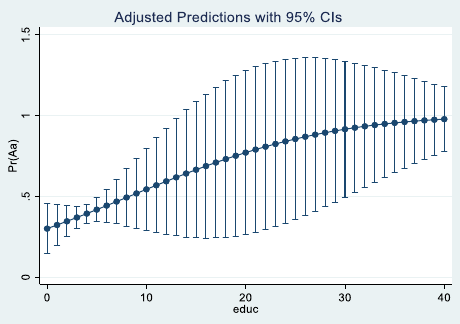
Figure 8. The non-linear impact of education level on the probability to adopt accumulated assets as a risk management strategy.